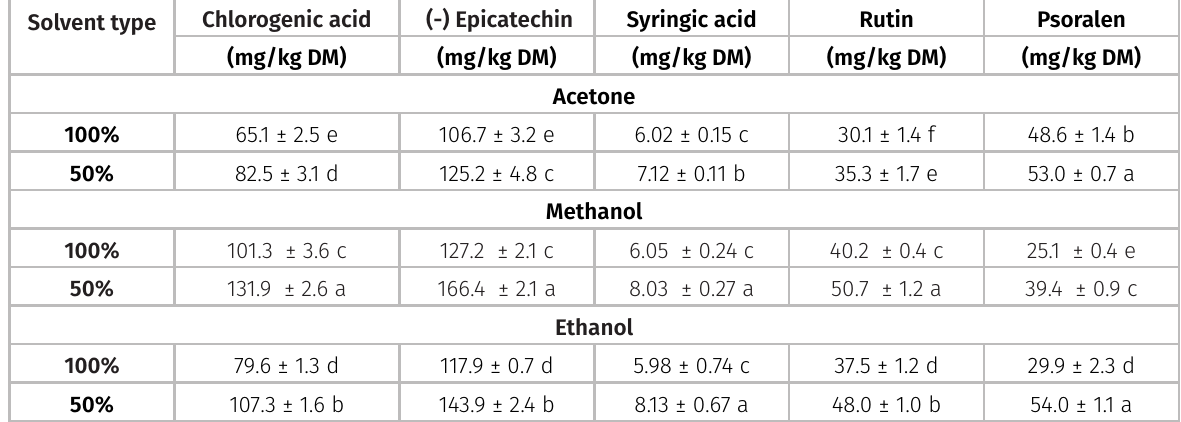
Table II. Effect of various solvent on the recovery of the polyphenols from the fig seeds (n = 3 ± S.D.). Solvent